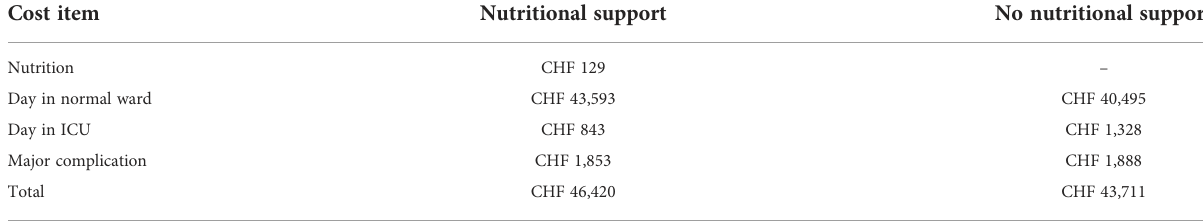
TABLE 1 Cost-effectiveness of nutritional support vs. no nutritional support in the EFFORT trial oncology subgroup over 30-days. CHF, Swiss franc. Cost